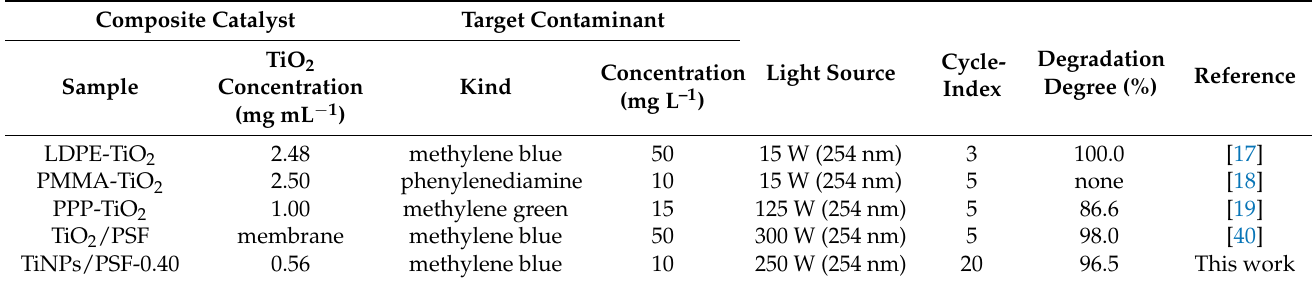
Table 4. The photocatalytic degradation of TiO 2 − and polymer composites under ultraviolet light/visible light irradiation.